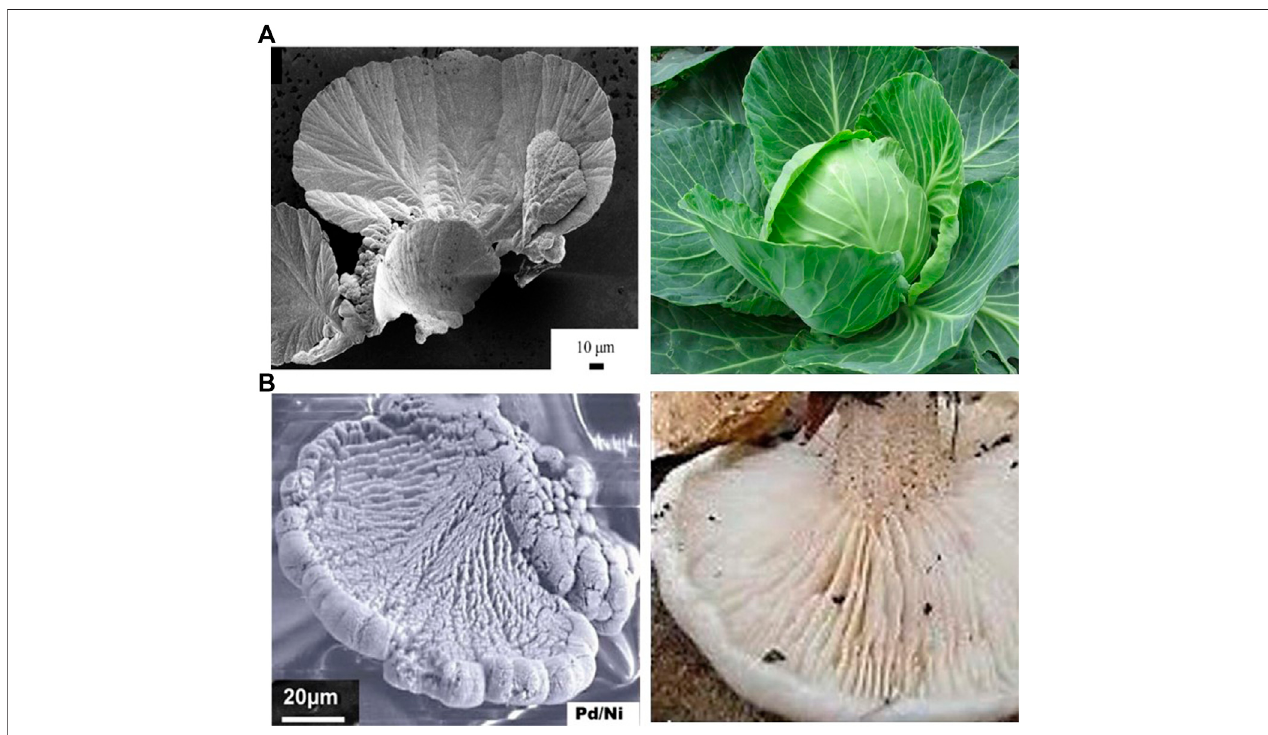
FIGURE 9 | (A) SEM image of electrodeposited silver HSS using Al 2 O 3 as a porous template (Reprinted with permission of MRS Proc. 1498 (2013) 183 – 188. Copyright©MaterialsResearchSociety2013)ascomparedtoaCabbageleaf (Brassicaoleraceavar.capitata) (CC0licenseforPublicDomain.Availableon:https://pixy. org/5824507/) (B) SEM image of a hierarchical Pd-Ni alloy versus the photograph of the fruiting body of a fungus (Reprinted with permission of MRS Proc. 1498 (2013) 183 – 188. Copyright© Materials Research Society